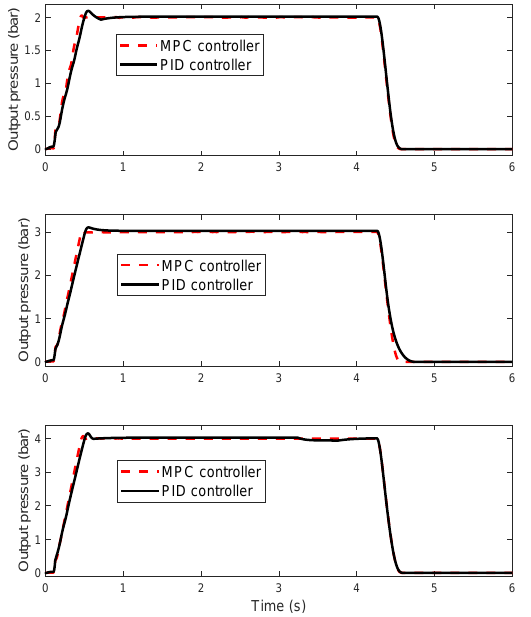
Figure 6. Comparison results between the PID controller and the MPC controller.